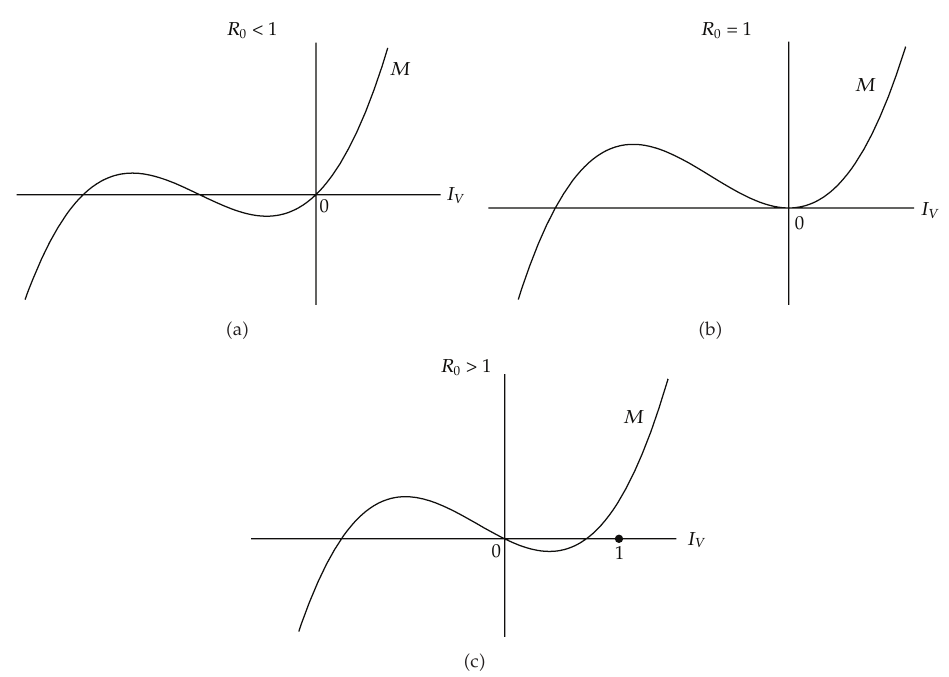
Figure 2: Three typical graphs of the polynomial M in (cid:5) 3.6 (cid:6) with respect to three conditions of R 0